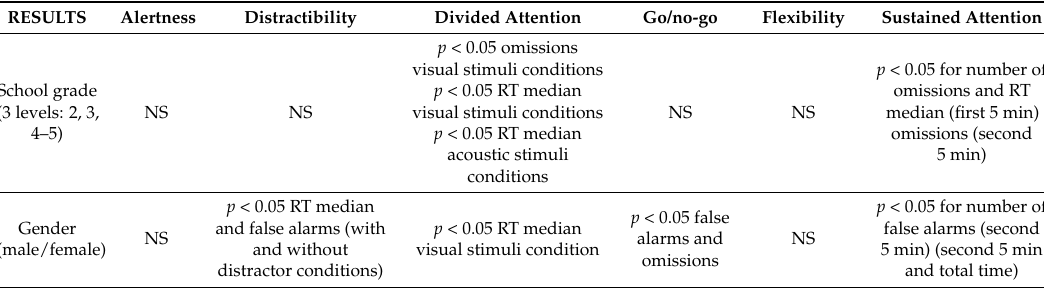
Table 6. Summary of hierarchical regression